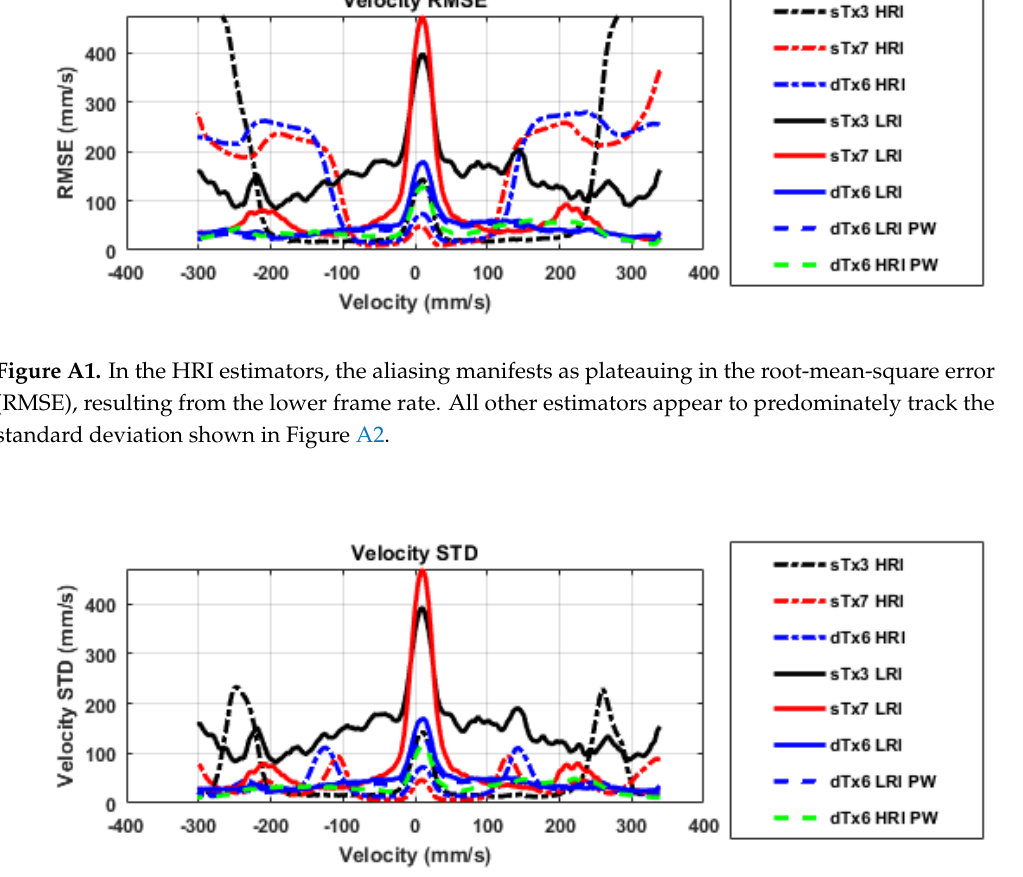
Figure A2. For the traditional HRI estimators, error resonates at the Nyquist velocities, likely due to the aliasing. The sTx3 LRI estimator appears to have uncharacteristically high error across the velocity range, suggesting that the individual LRIs are highly decorrelated, possibly due to a high angular step. In the sTx7 LRI dataset, the error resonates at the velocity associated with the transmit sequence period, likely due a combination of sidelobe motion and attenuation due to the clutter filter. The dTx6 estimators do not have a corresponding peak, suggesting an inherent robustness to these effects.